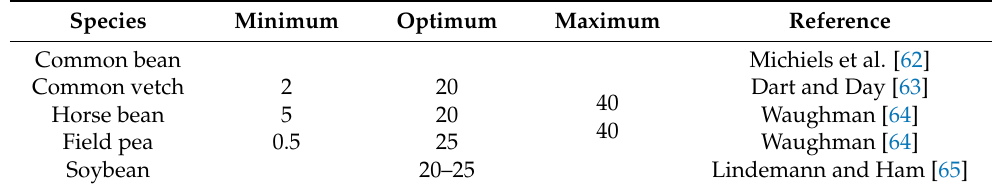
Table 2. Response of BNF of selected legumes to soil temperature (in